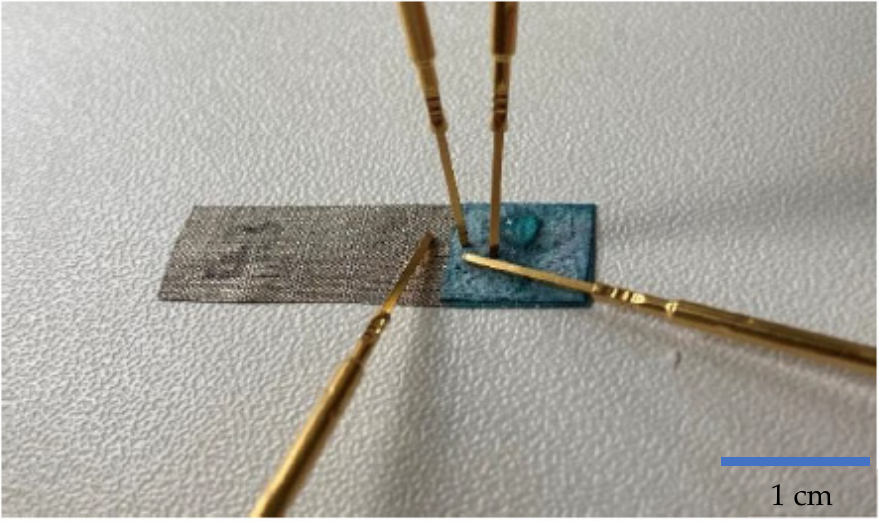
Figure 11. Detection of salt solution on the surface of source/drain electrode.